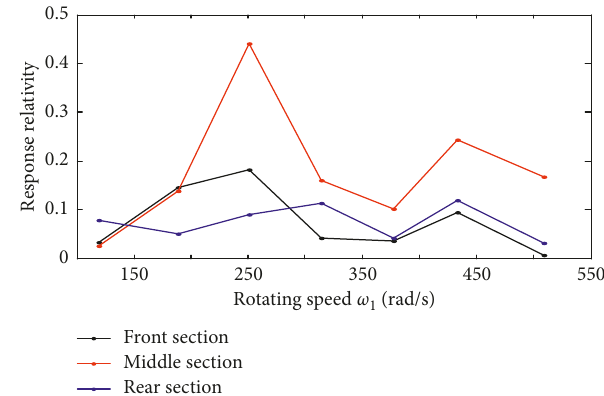
Figure 23: Experimental response relativity R with varying rotating speed of low-pressure rotor ω l : front section (black), middle section (red), and rear section (blue).